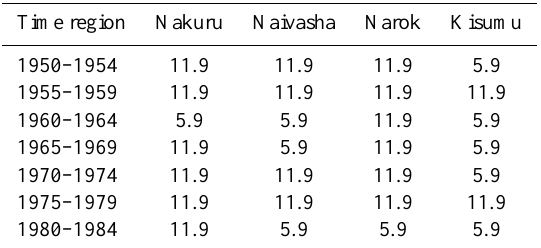
Table 5. Monthly periodicities every five years of the representative harmonics time series [month] from 1950 to 1984. The main peri- odicities in Nakuru, Naivasha, and Kisumu transiently change from annual cycle to semiannual cycle in the 1960’s. Time region